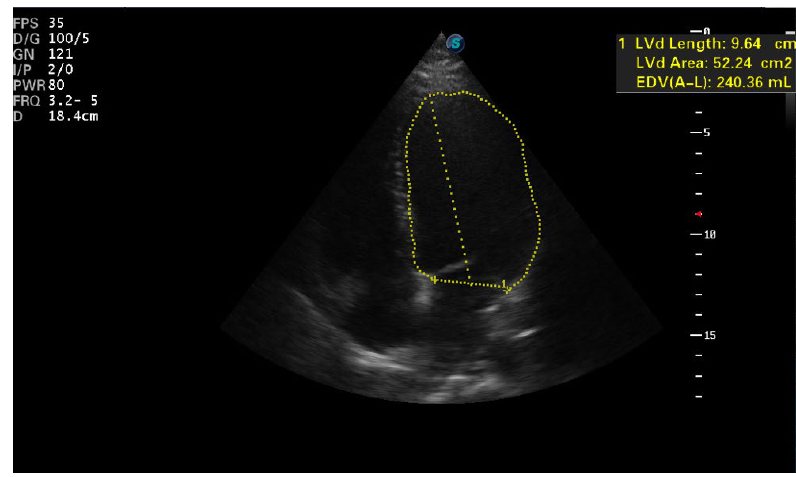
Figure 1. Case 1—TTE left ventricle tele-diastolic volume evaluation (yellow dotted line).